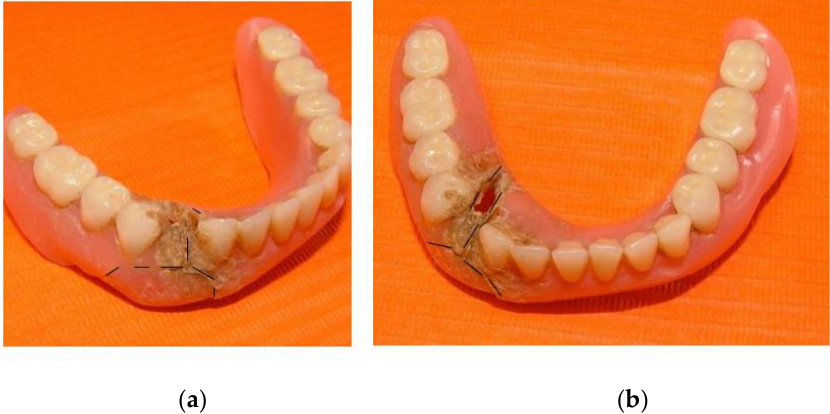
Figure 1. Prosthesis repaired by the patient: (a) lateral view; (b) : frontal view.